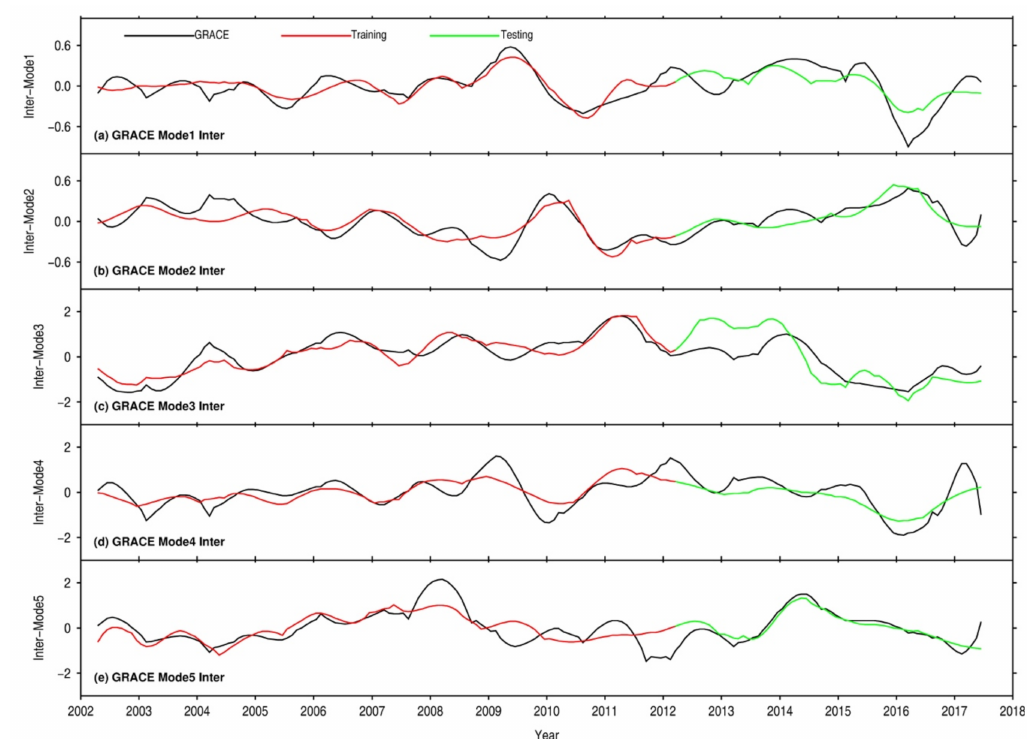
Figure A2. Interannual components of the five leading GRACE temporal modes (black lines) relative to the model outputs in the training (red lines) and testing periods (green lines).